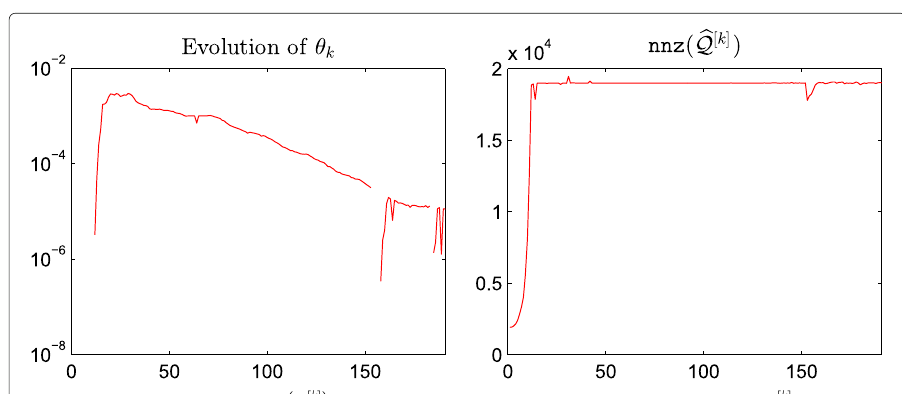
(cid:5) (cid:4) FBsoc: behaviour of θ k and the number of nonzerso in Q [ k ] with Q [ k ]